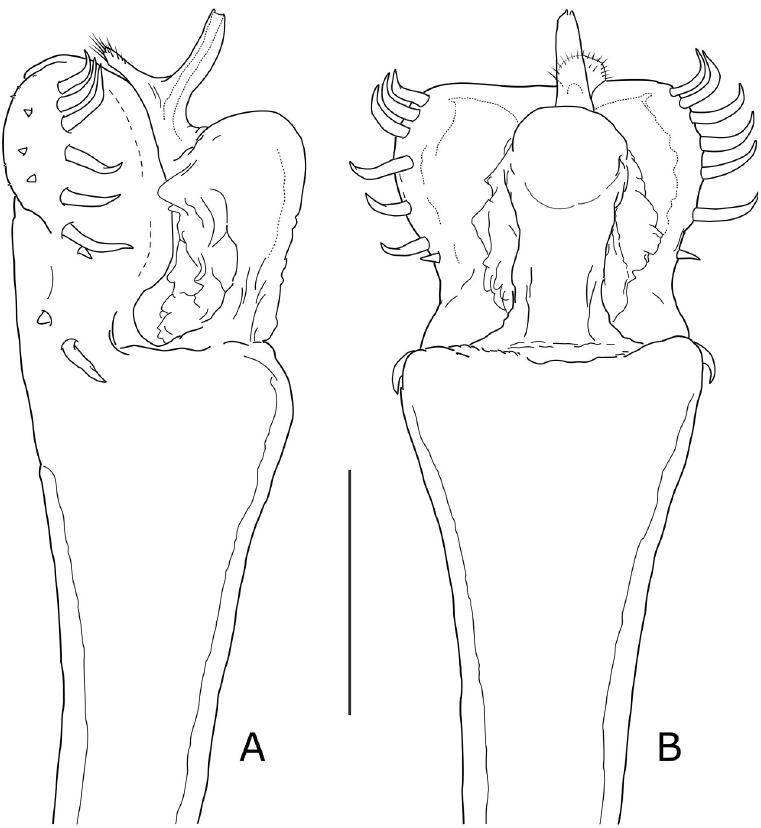
Fig 7. Osornogyndes tumifrons Maury, 1993, paratype male (MACN 9117), distal end of penis. A. Lateral view; B. Dorsal view. Scale bar: 0.1 mm.